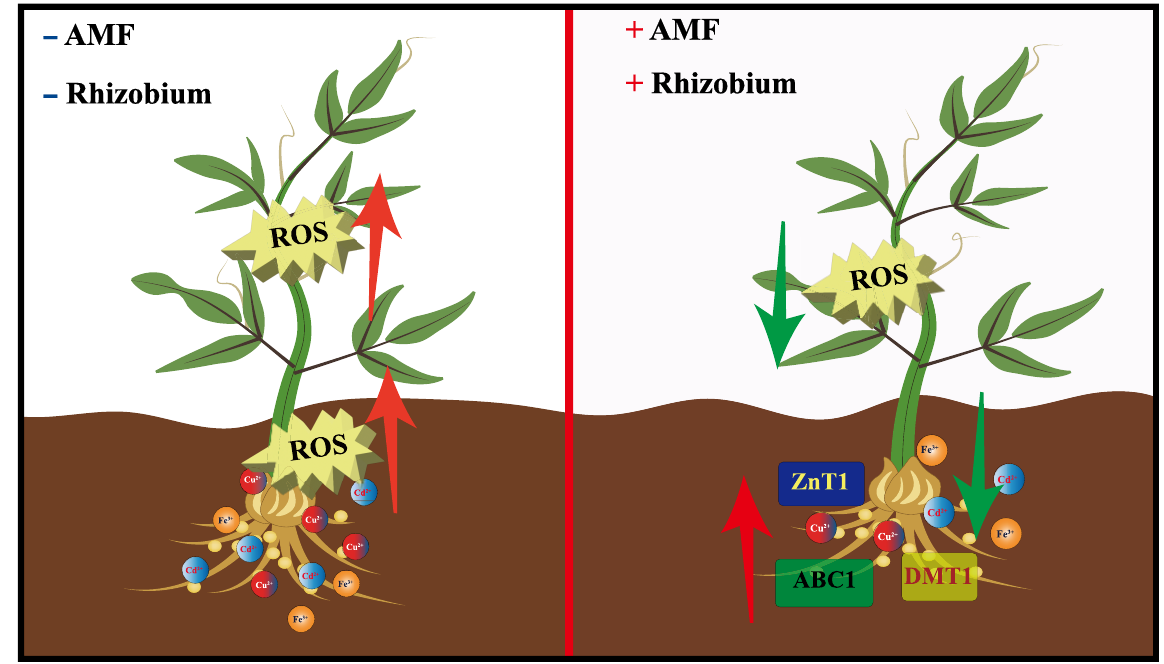
Figure 7. Effects of double inoculation of Rhizobium with AMF on plant growth. After double inoc- ulation with AMF and Rhizobium, the content of ROS in plants decreased, the expression of ABC1, DMT1, and ZnT1 genes increased, which promoted the transport and absorption of Cd 2+ , Cu 2+ , and Fe 3+ , thus achieving the effect of reducing the concentration of TMs. Table 3. Effects of Rhizobium and AMF on plants in tripartite symbiosis in recent years.